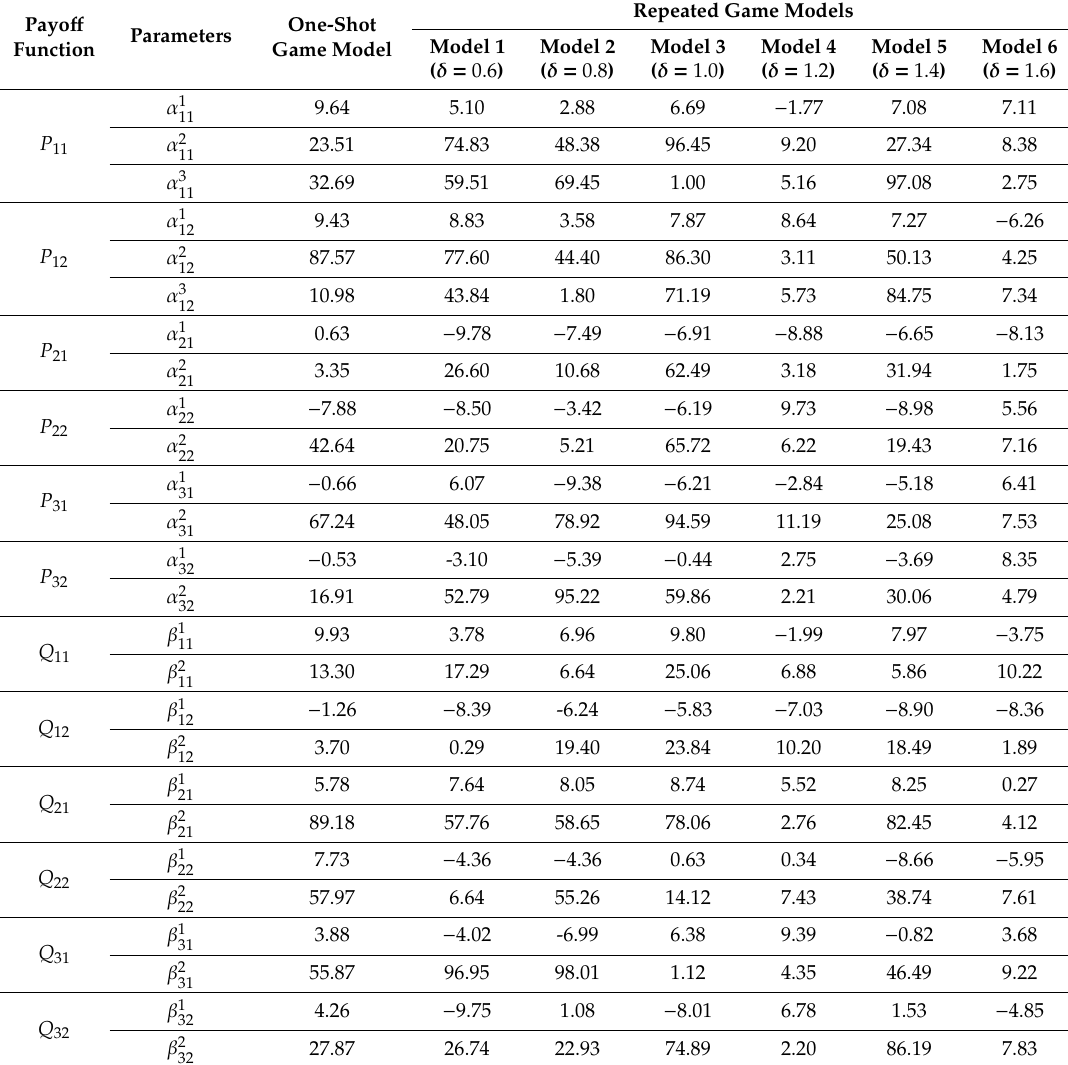
Table 2. Estimated Parameters of the Payo ff Functions for Game